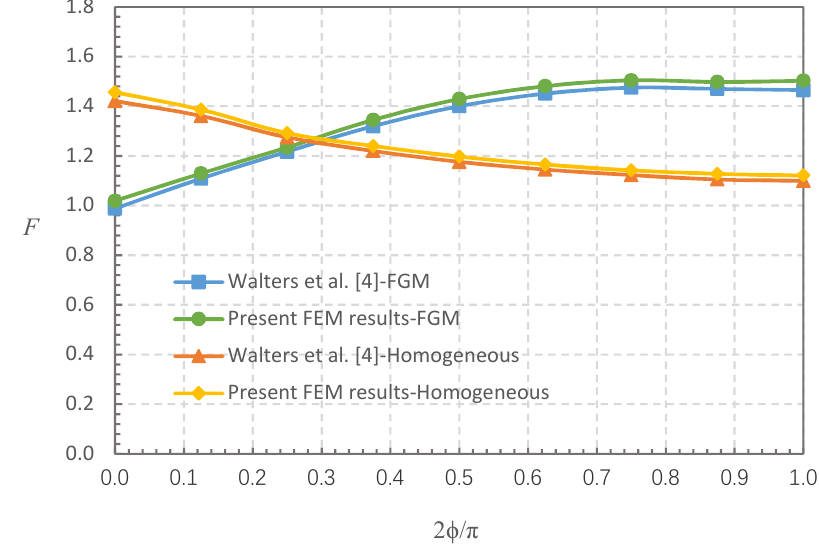
Figure 4. Comparison of BCFs ( F ): FEM results in this study vs. results in reference [4], for a / t = 0.8, a / c = 1, E (1)/ E (0) = 5, and homogeneous material.